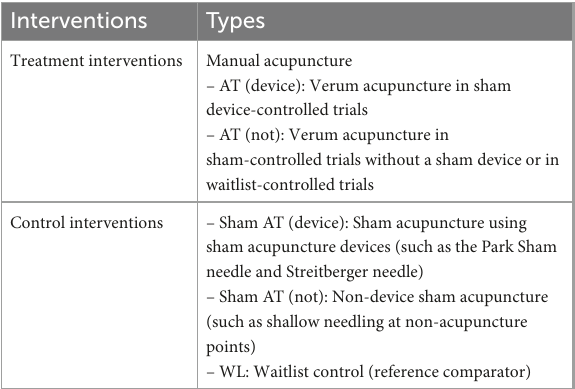
TABLE 1 Eligibility intervention criteria of the